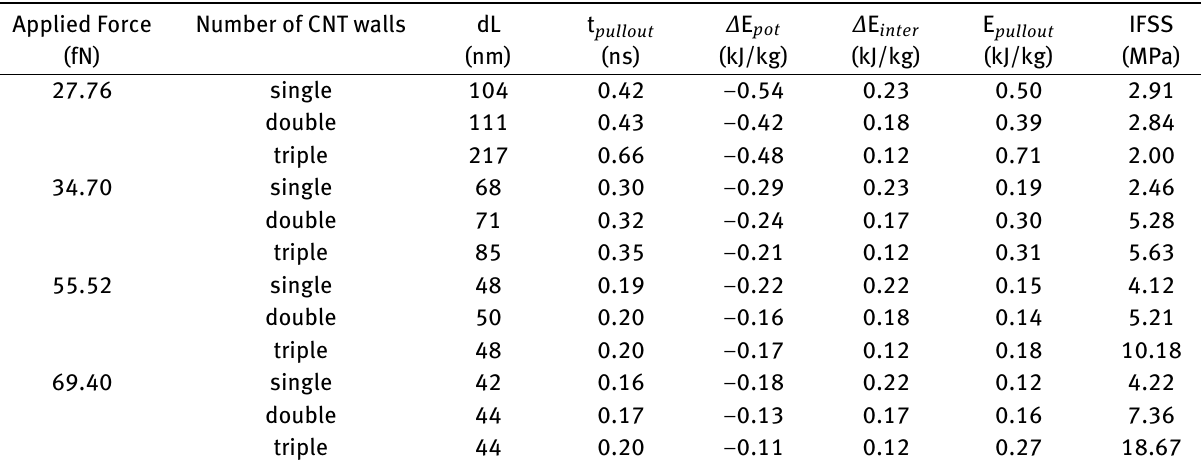
Table 1: Summary of the results from the pullout tests for the CNT-PI nanocomposites Applied